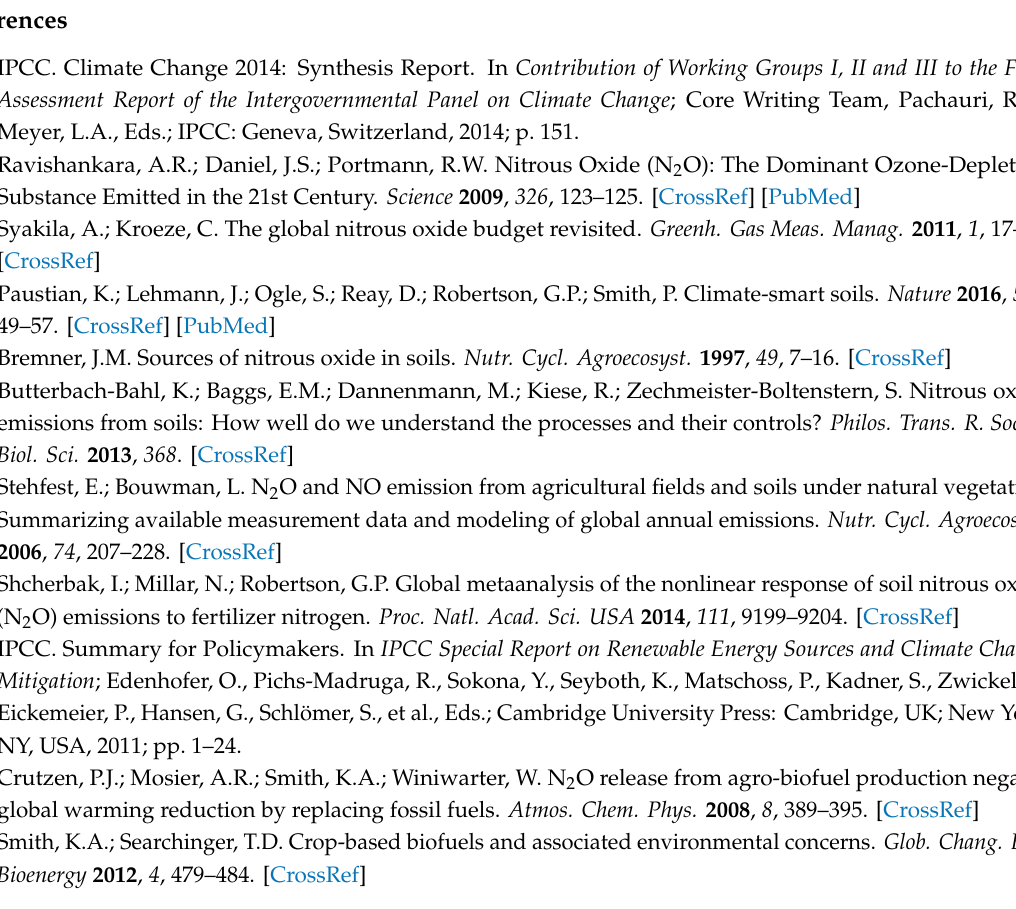
Table S1: Biomass production measured at harvest for the di ff erent treatments included in the study, Table S2: Soil characteristics (0–30 cm) of the 15 plots of the B&E experiment used for N 2 O measurements, Table S3: Cumulative N 2 O emissions for the di ff erent periods of monitoring for each